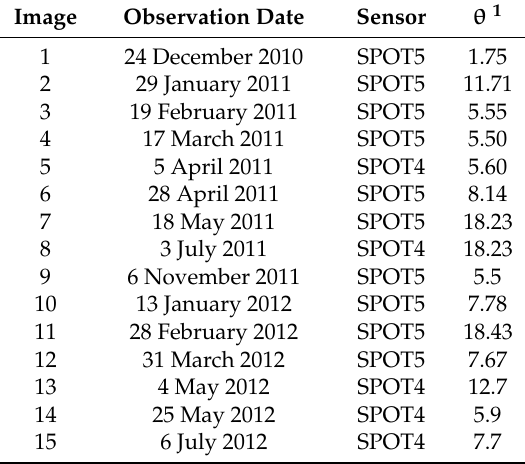
Table 1. Satellite acquisition dates.